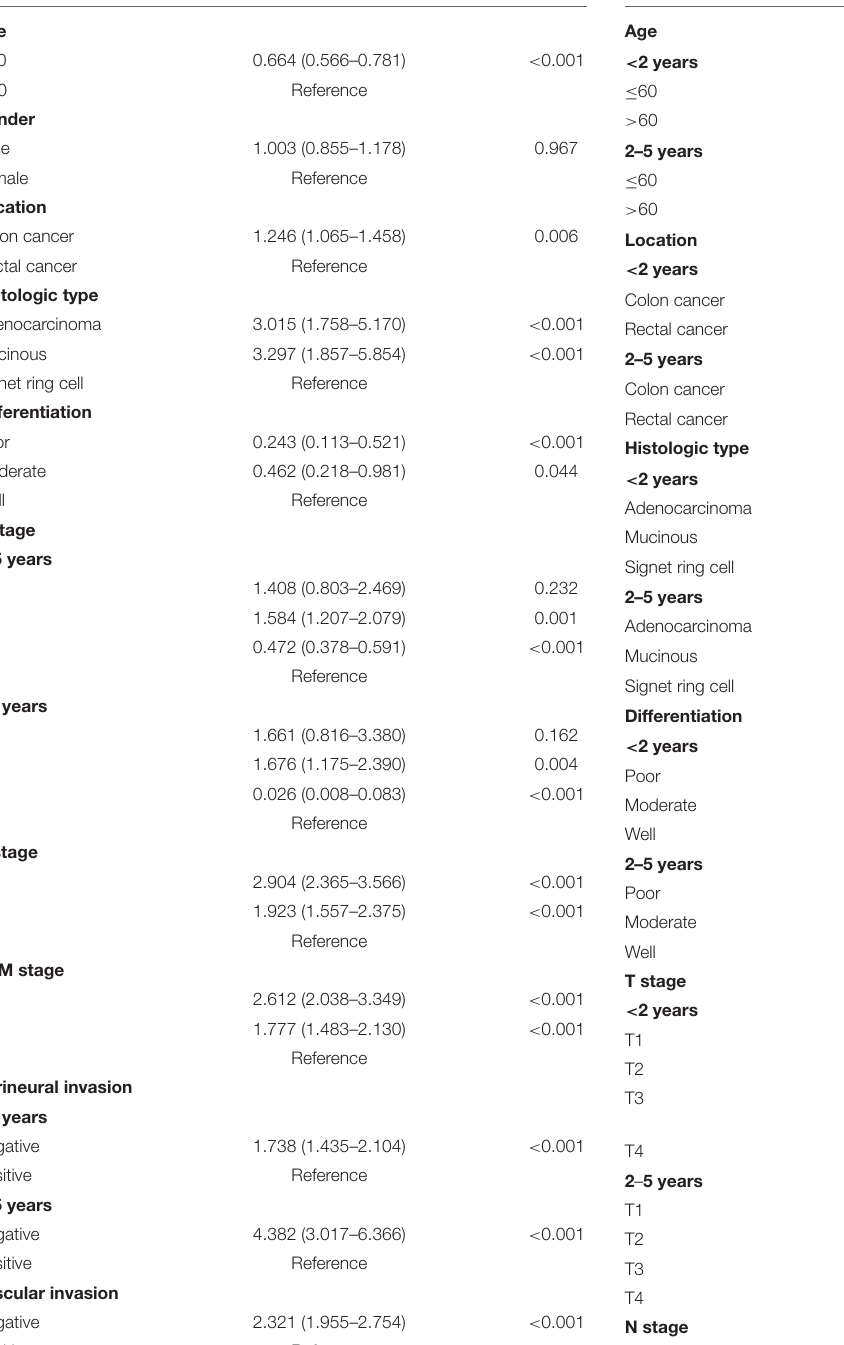
TABLE 3 | Multivariate multinomial logistic regression analysis of the factors associated with recurrences < 2 years, 2–5 years, and > 5 years after radical surgery ( > 5 years as a